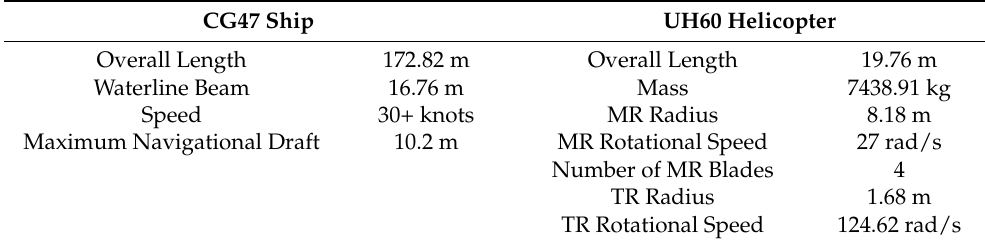
Table 2. Main parameters of CG47 ship and UH60 helicopter.